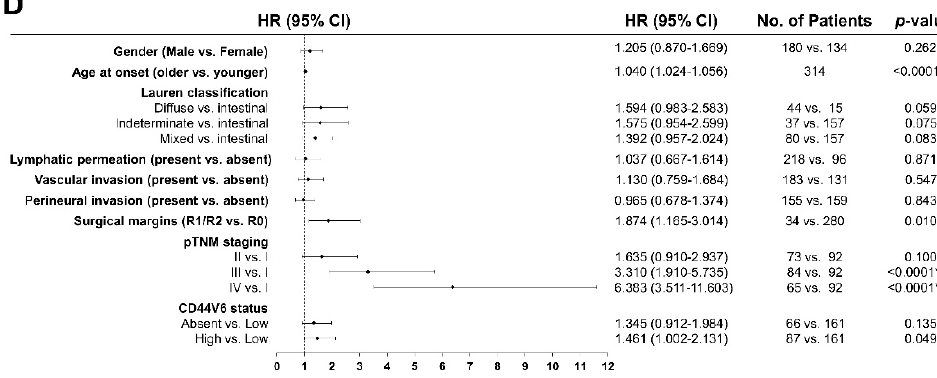
Figure 1. ( A ) Immunohistochemistry characterization of tumor samples for the presence and extent of CD44v6 expression. Images are representative of the five categories defined. Scale bar represents 50 µm; Kaplan–Meier estimates showing OS from CHUSJ GC patients, according to CD44v6 sub- categories ( B ) or according to CD44v6 status (absent, low, and high expression) ( C ). Median OS and 5-year OS are shown for each patient subgroup. p -values for pairwise comparisons by the Log-Rank (Mantel–Cox test) are shown in Tables S4 and S5, respectively; ( D ) Forest plot of the multivariate analysis. * highlights statistically significant differences.